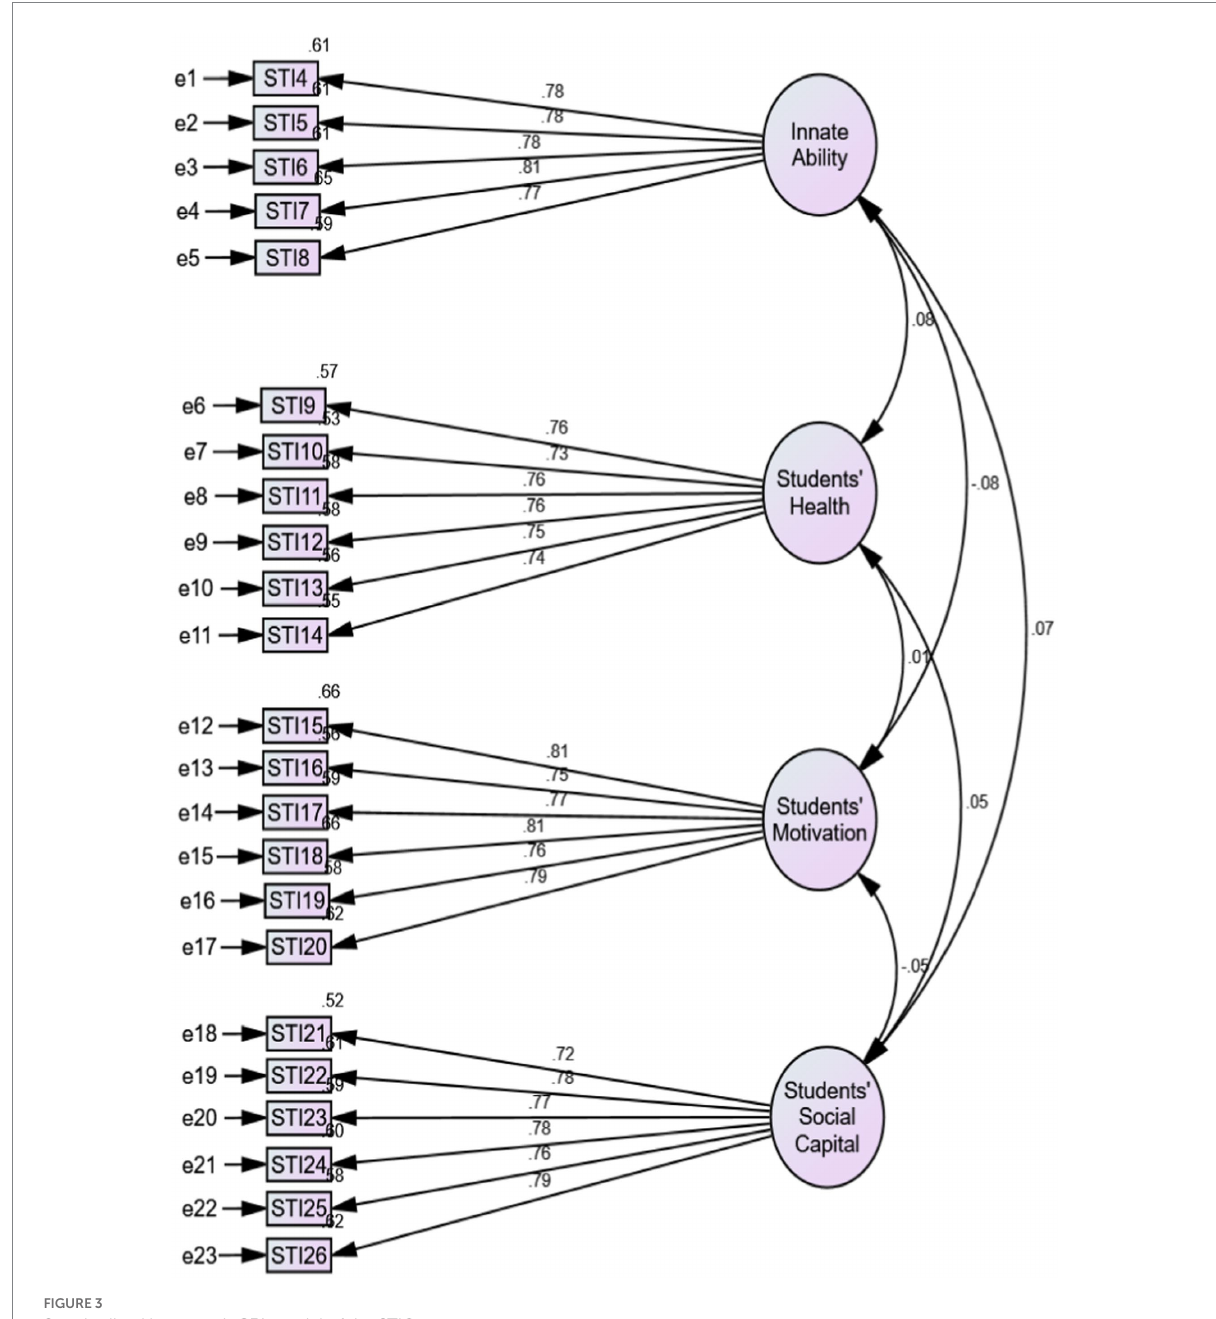
FIGURE 3 Standardized latent-trait CFA model of the